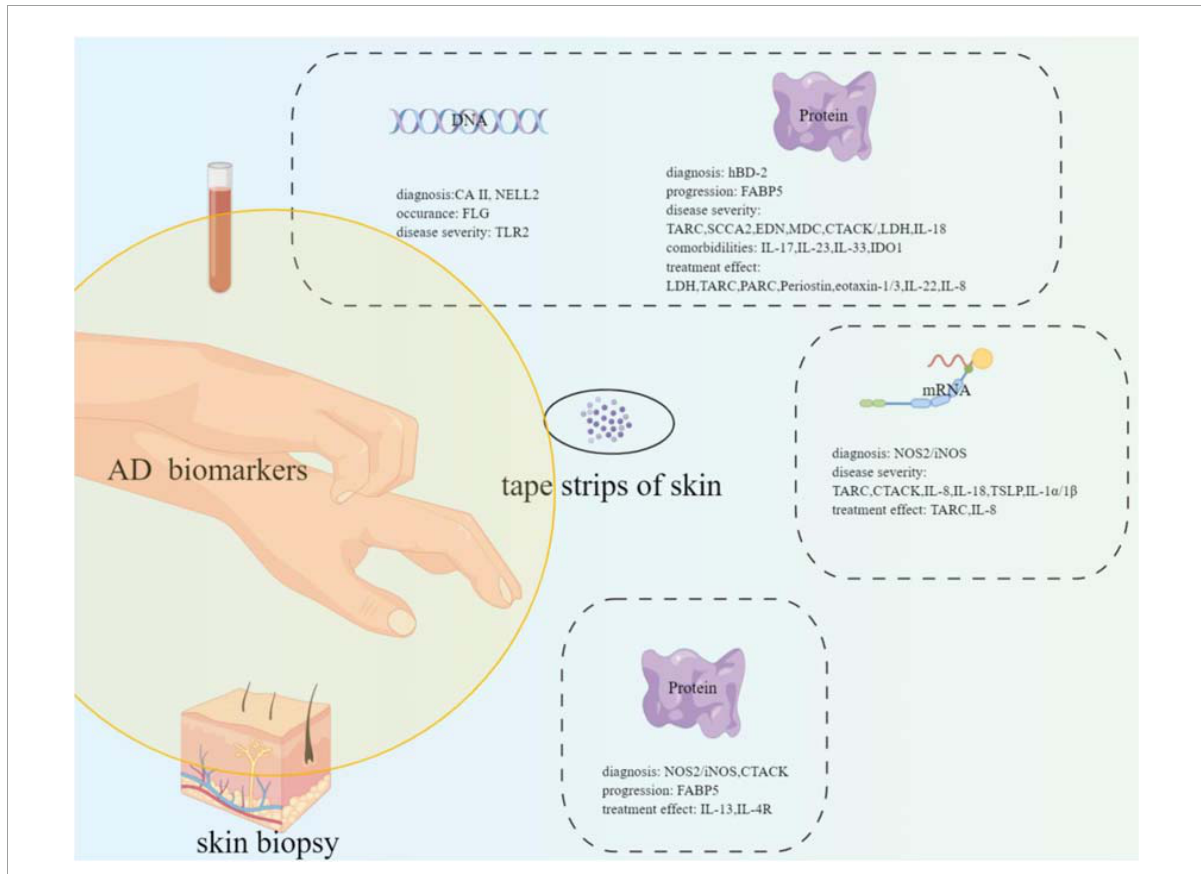
FIGURE1 Summary of the potential biomarkers of atopic dermatitis with different samples (blood, tape strips of skin, and skin biopsy) from the